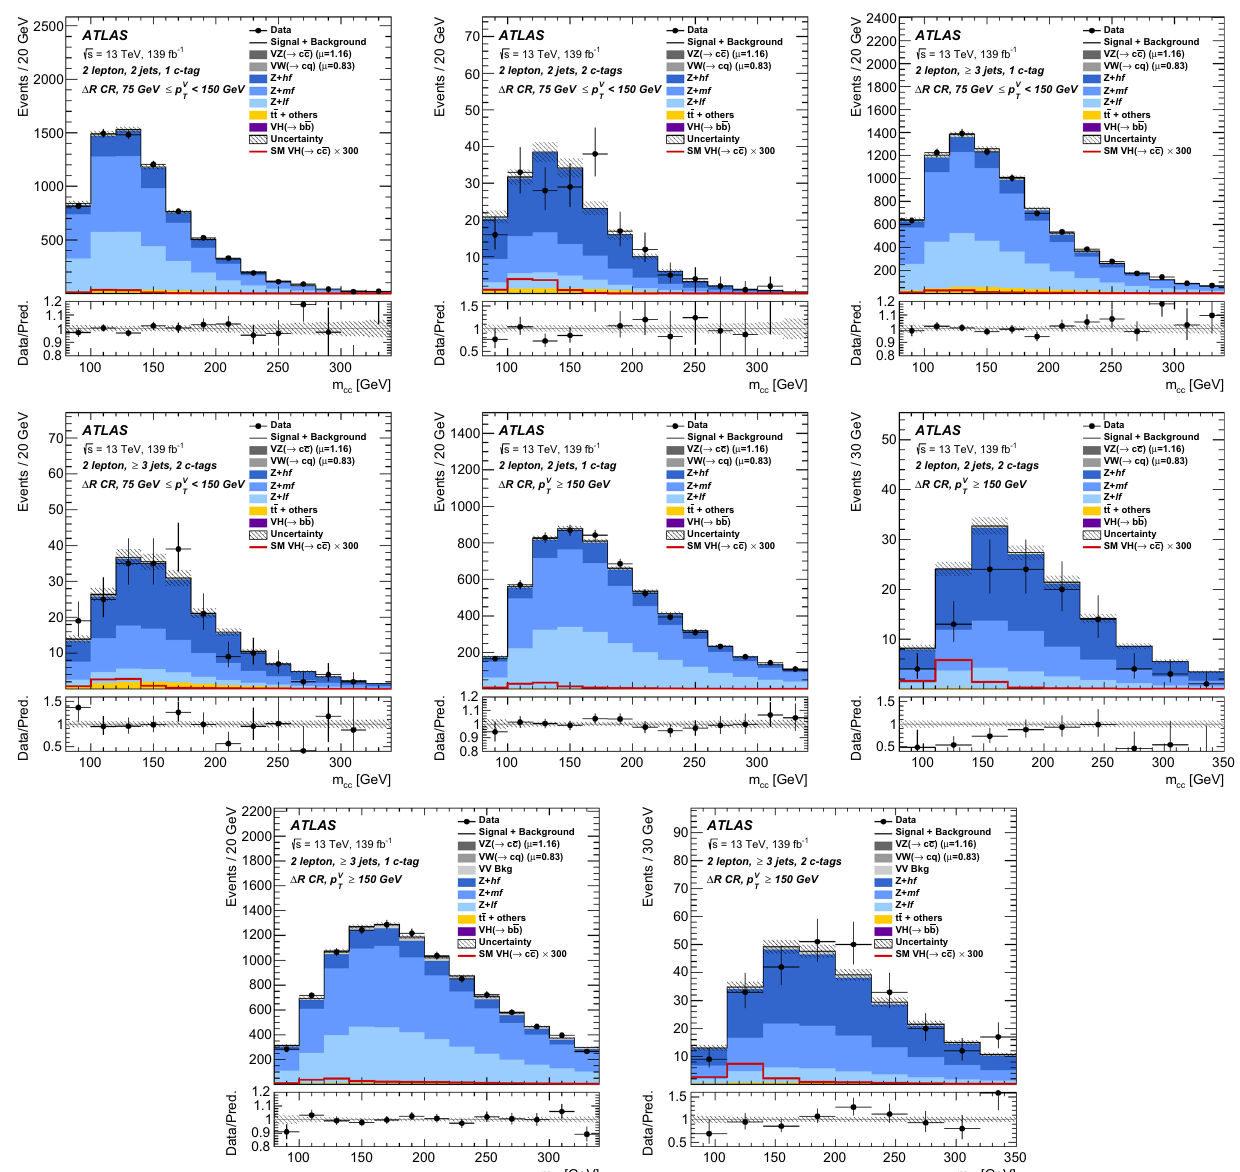
Fig. 13 Post-fit distributions of the eight 2-lepton high- (cid:11) R control regions. The total signal-plus-background prediction is shown by the solid black line and includes the H → c ¯ c signal scaled to the best- fit value of μ VH ( c ¯ c ) = − 9. The H → c ¯ c signal is also shown as an